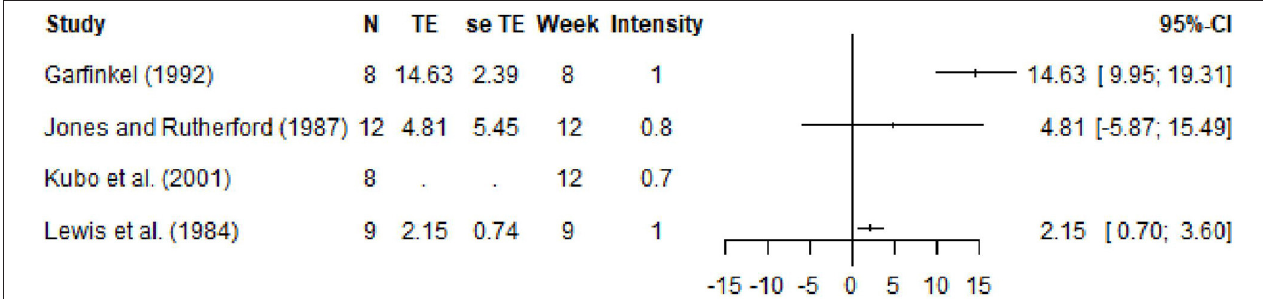
FIGURE 6 | Forest plot for the data on volumetric changes. Here N denotes the number of subjects, TE and se TE denote the mean and standard deviation of the treatment effect, week denotes the time point and intensity denotes the training intensity. A training intensity of 1 corresponds to 100% MVC.